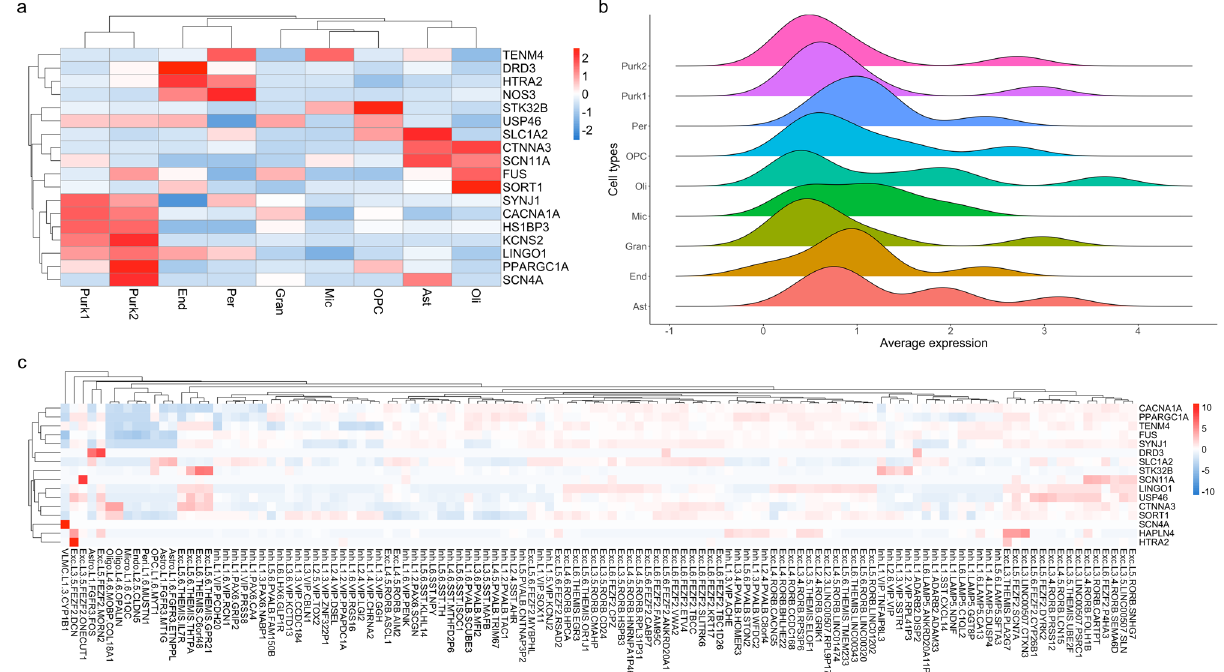
Fig. 4 Single-cell enrichment of ET genes in cerebellar and cortical tissues. a Single-cell enrichment Z -score heatmap of ET-related genes in adult cerebellar tissue. Rows represent ET genes; columns represent cell types of the cerebellum (Purk1 SORC3 + Purkinje cells, Purk2 SORC3 − Purkinje cells, Ast Astrocytes, OPC Oligodendrocyte progenitor cells, Oli Oligodendrocytes, Mic Microglia, End Endocytes, Gran Granule cells, Per Pericytes). b Ridge plots displaying distribution of average expression counts of ET-related genes in different cell types of the adult cerebellum. c Z -score expression heatmap of ET genes in single-cell types of the adult cortex. Rows represent ET genes; columns represent cortical cell types (Exc Excitatory, Inh Inhibitory, Astro Astrocytes, End Endocytes, Peri Pericytes, VLMC vascular and leptomeningeal cells, OPC Oligodencrocyte progenitor cells, Oligo Oligodendrocytes, L# cortical